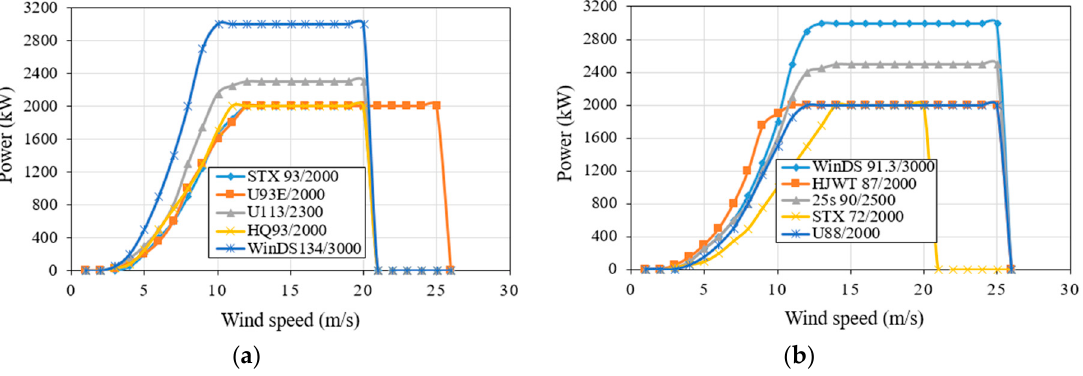
Figure 9. Power curves of selected wind turbines ( a ) Deokjeok-do and Baengnyeong-do; ( b ) Seo-San.